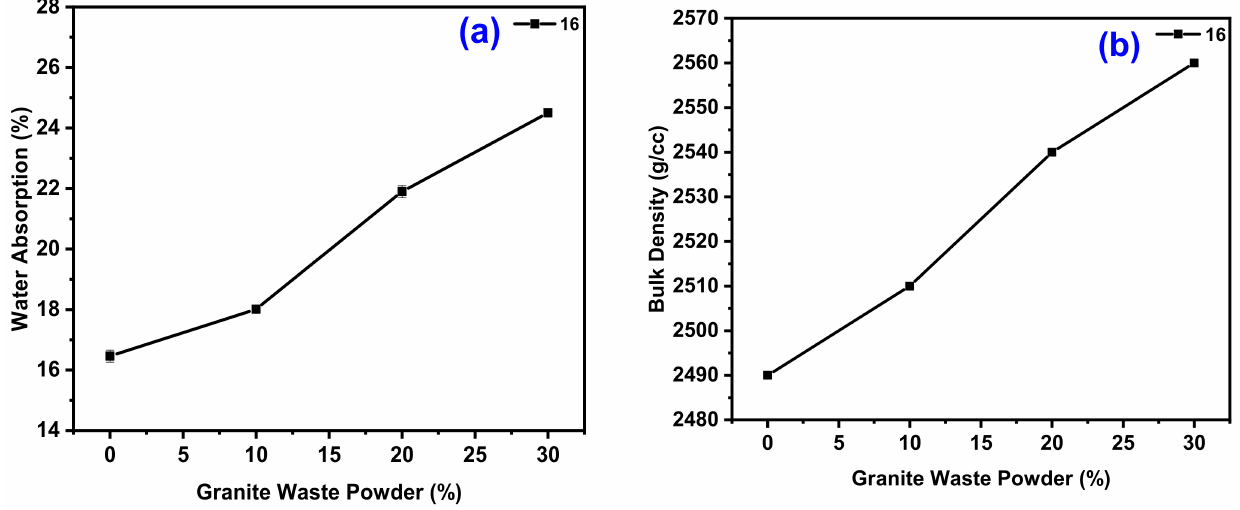
Figure 5. Variation of GWP on the different molarity for the WB ( a ) and BD ( b ) properties, respectively. Increases in the liquid/solid ratio result in a decrease in the activator molar and alkalin- ity and a decrease in its impact on the FA-GGBS matrix. However, raising the liquid/solid ratio lowers the pores in the macrostructure, resulting in denser GPC with abundant silicon compared to GGBS and GWP with a larger amount of CaO than GGBS. Geopolymer gel is created when reactive alumina reacts with an alkaline substance [18,62,71]. When the geopolymer paste is exposed to vibration during the GPC manufacturing process, the geopolymer paste bleeds, and the gel increases. The aggregate effect prevents the gel